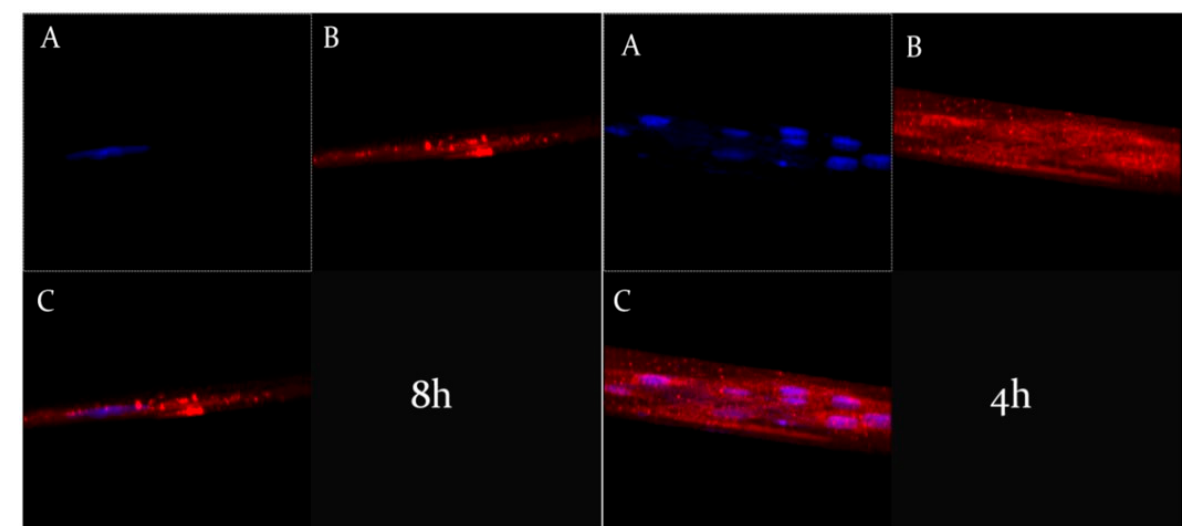
Figure 7. Z-stack analysis of CaCo-2 human colorectal adenocarcinoma cells treated with rhodaminated formulation (A) (left) and (B) (right), after 8 h and 4 h of incubation, respectively. ( A ): Hoechst filter; ( B ): TRITC filter; and ( C ): Overlay.